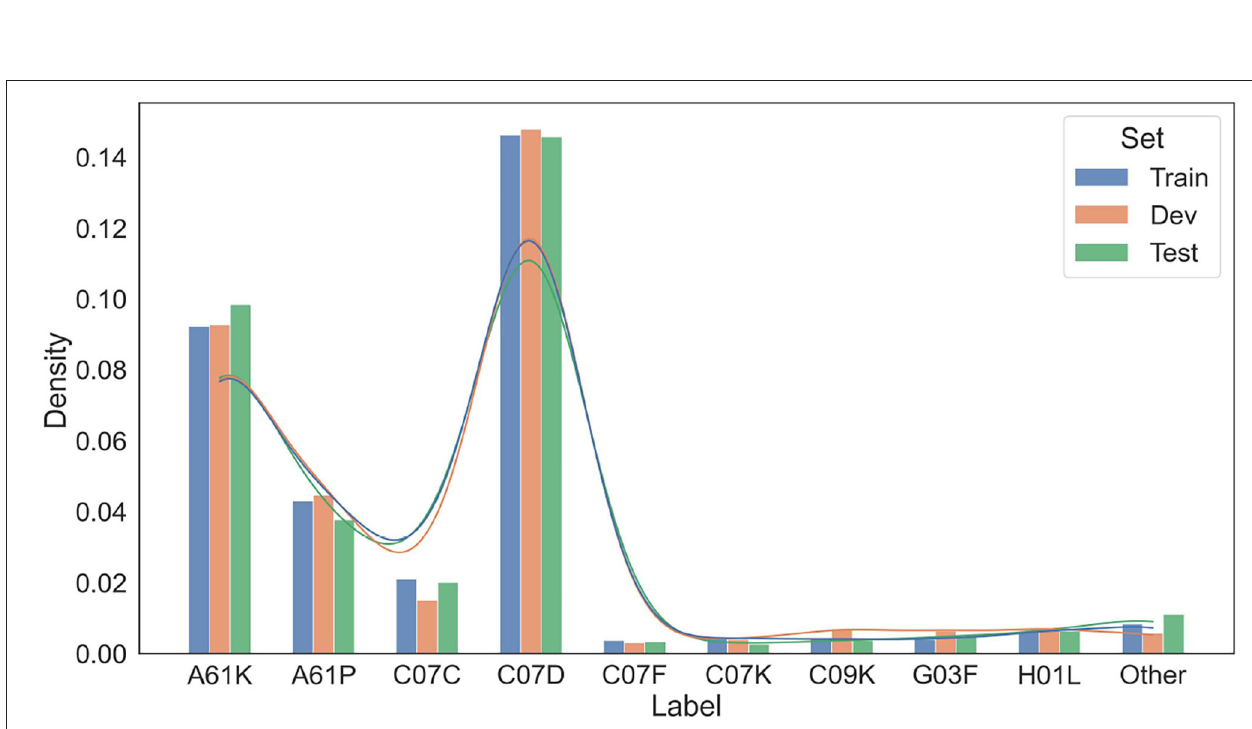
FIGURE 5 | Distributions of IPCs on the training/development/test data splits. Only dominating IPC groups that take up more than 1% of at least one data split are included in this figure. Other IPCs are grouped as “Other”.